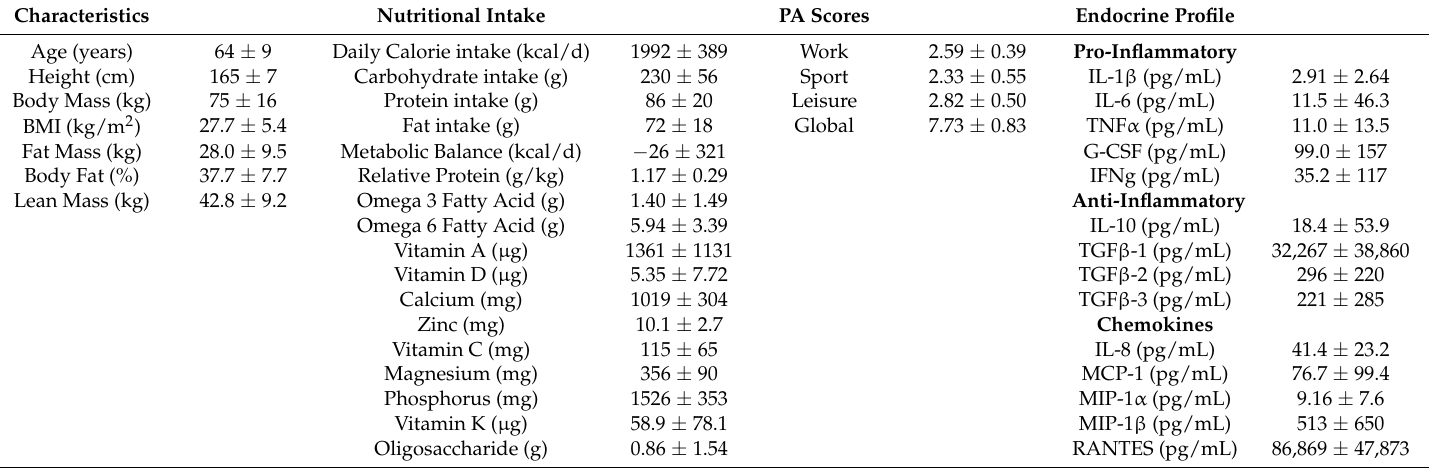
Table A1. Participants’ anthropometric, nutritional, physical activity (PA) and endocrine characteristics.